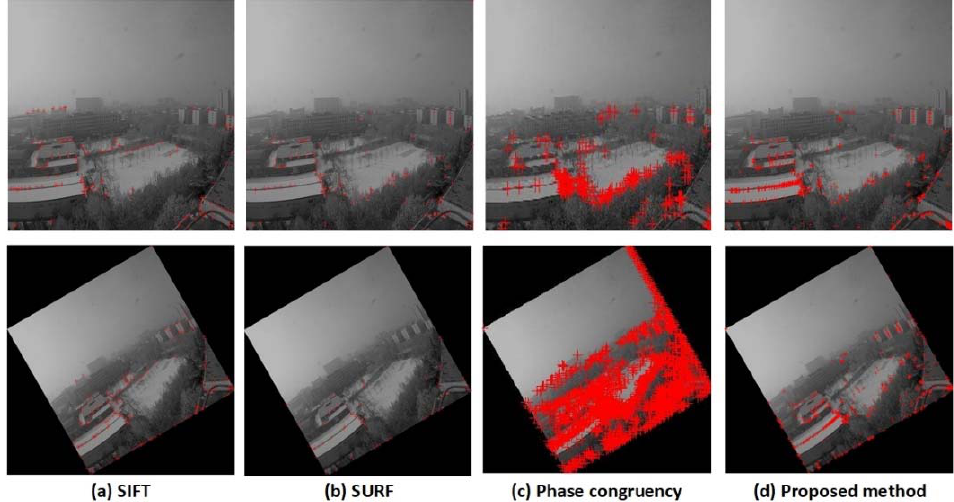
Figure 9. The result of the feature point extraction algorithm, in this paper, in the rotated image. ( a ) represents the result of the SIFT algorithm, ( b ) represents the result of the SURF algorithm, ( c ) represents the result of the Phase congruency algorithm, ( d ) represents the result of the proposed algorithm